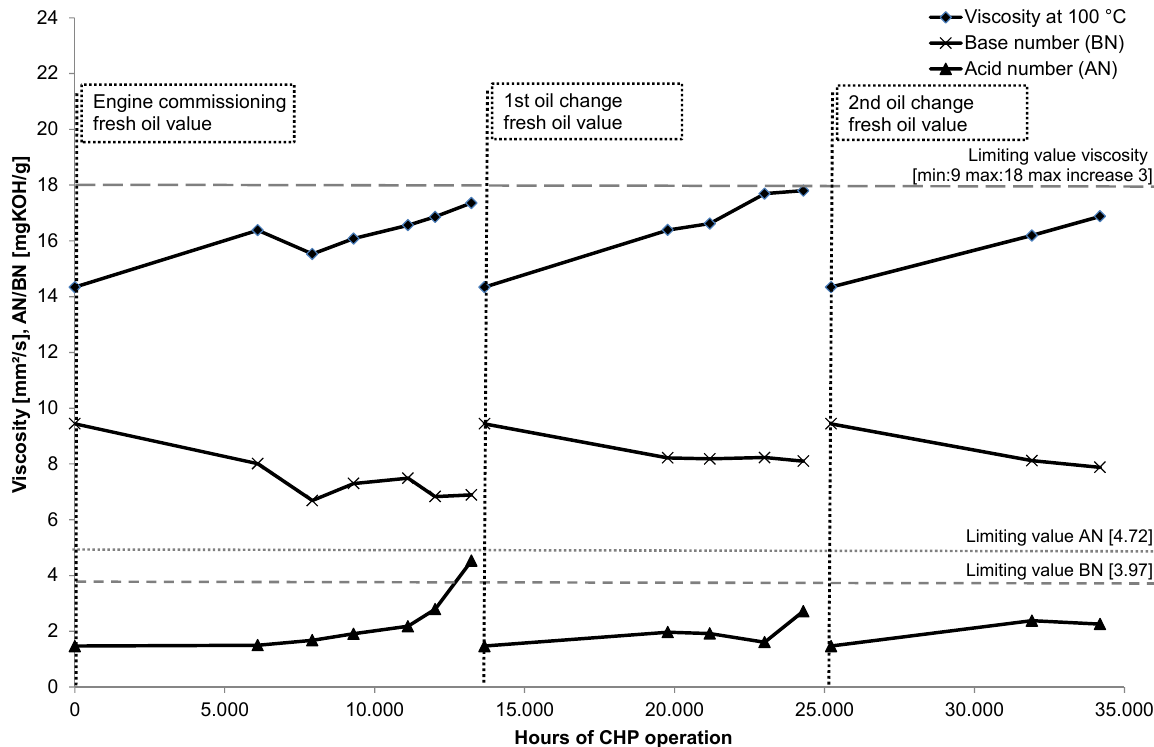
Figure 5. Results for viscosity, base (BN) and acid number (AN) complemented by fresh oil values at times of oil